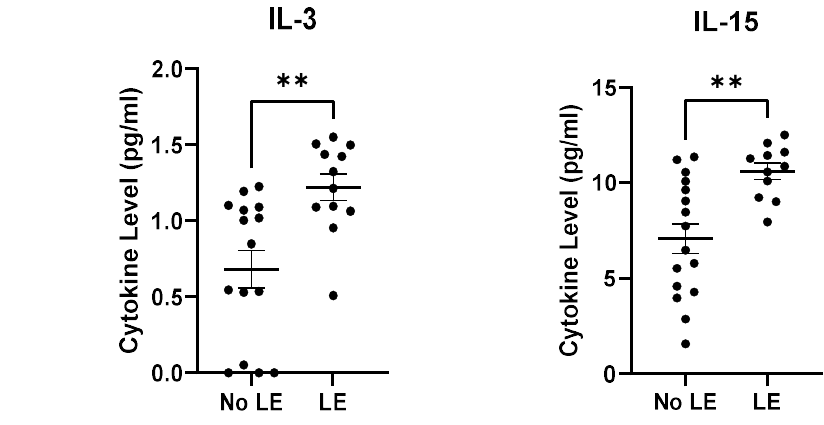
Figure 3. Pre-ALND plasma cytokine/chemokine levels were elevated in subjects displaying clinical BCRL/LE at 12-months post-RT. Of the 14 cytokines analyzed, only IP10 and TNF- α were not significantly elevated. * p ≤ 0.05, ** p ≤ 0.01, *** p ≤ 0.001, ns = p > 0.05. 3.2. Several Plasma Cytokine/Chemokine Levels Were Elevated at 12 Months after RT in Those with Clinical BCRL Plasma IL-15, IL-3, and MIP-1 β levels were found to be significantly higher at 12-months post-RT in comparison to those who did not display BCRL at 12-months post-RT (Figure 4). Other plasma cytokine/chemokine levels did not reach significance, but several trended upwards (Figure S1).